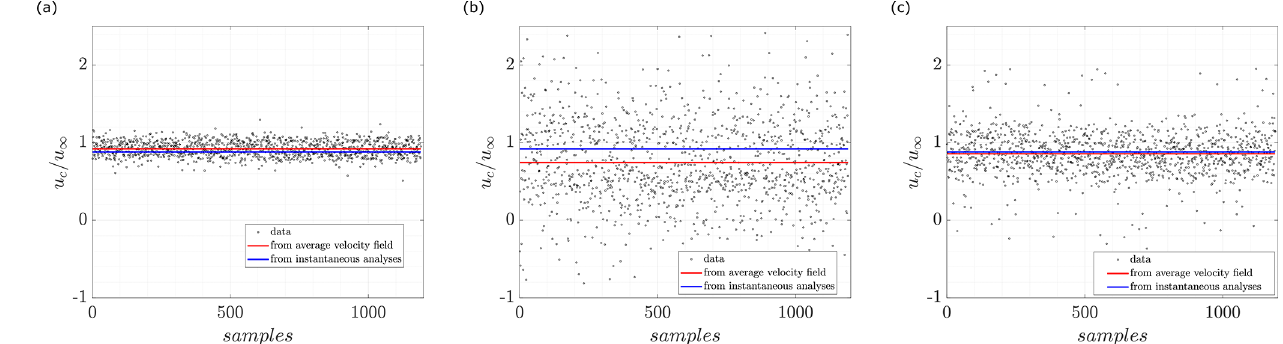
Figure 16. Normalized convection velocity in the streamwise direction. (a) Graftieaux. (b) Vorticity magnitude and central differentiation scheme. (c) Vorticity magnitude and least-squares scheme.